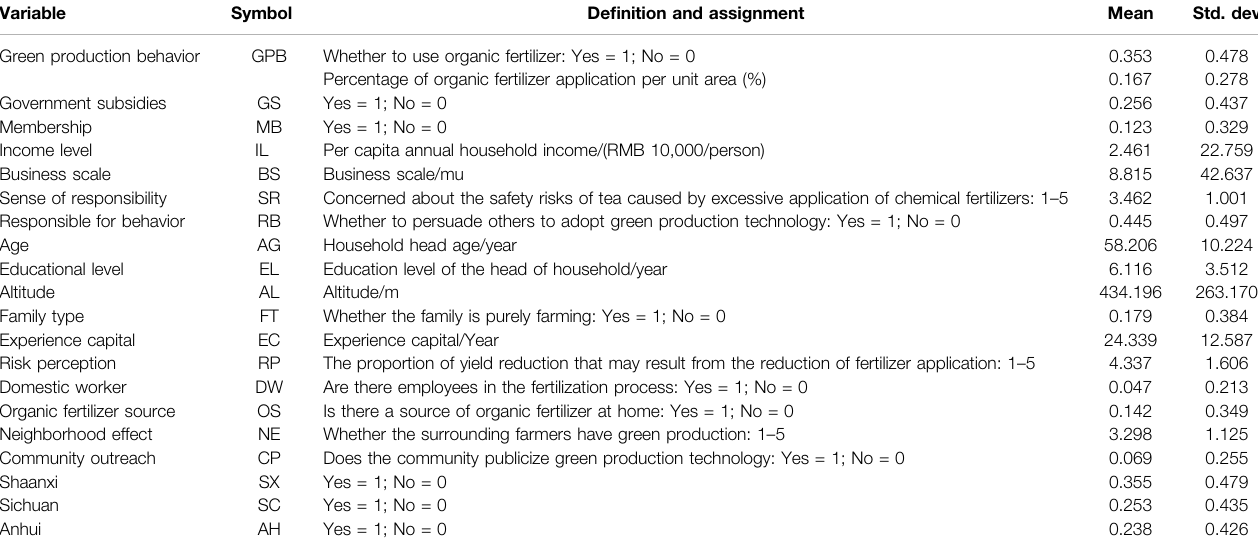
TABLE 1 | Variable description and descriptive statistics. Variable